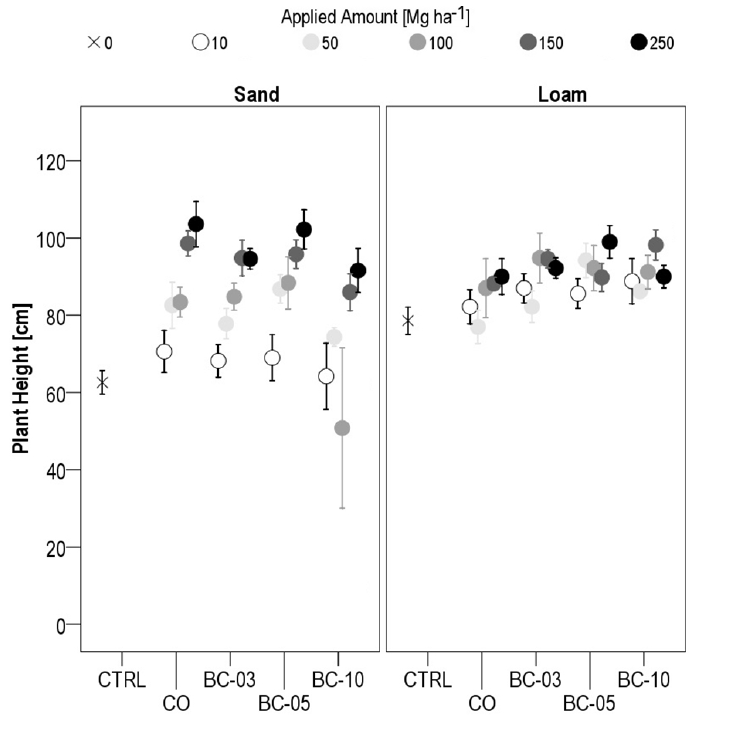
Figure 3. Plant height of oat ( Avena sativa L.) in cm on sandy ( top ) and loamy substrate ( bottom ) depicted for five treatments (CO = pure compost, BC-03 = compost with 3 kg Mg −1 w / w biochar, BC-05 = compost with 5 kg Mg −1 w / w biochar, BC-10 = compost with 10 kg Mg −1 w / w biochar) in five application amounts (10, 50, 100, 150, 250 Mg ha −1 ) versus control (CTRL = no amendment) ( n =